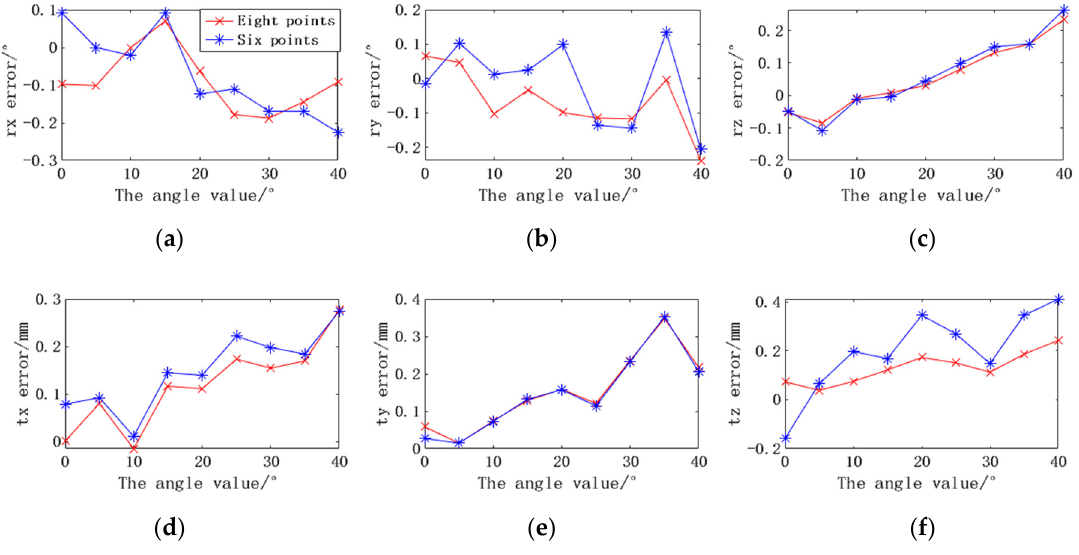
Figure 16. The pose errors based on eight markers and six markers at different angles. ( a ) Rotation error along the x-axis. ( b ) Rotation error along the y-axis. ( c ) Rotation error along the z-axis. ( d ) Translation error along the x-axis. ( e ) Translation error along the y-axis. ( f ) Translation error along the